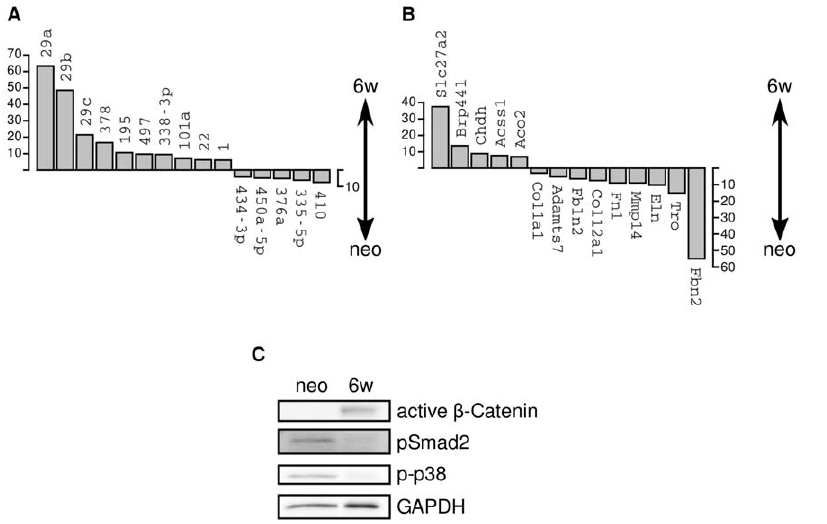
Figure 1. Shifts in mRNA and miRNA expression and TGF- b and Wnt pathway activity in postnatal aortic development. A The fold- change of the normalized expression levels of the most highly differentially regulated miRNAs as measured by microarray hybridization is displayed. B The fold-change of the normalized expression levels of the most highly differentially regulated mRNAs annotated to the GO terms mitochondrion (up-regulated at w6 ) and extracellular matrix (down-regulated at w6 ). (A,B) The fold-change between the neo and w6 aortic samples is shown with the direction of the change being indicated by the arrows. Data are presented as mean of three measurements ( n ~ 3 ). Each mRNA or miRNA had a Benjamini-Hochberg [68] corrected p v 0 : 01 and an absolute fold change of at least 2. C Western Blot analysis with antibodies against active b - catenin, phosphorylated Smad2, and phosphorylated p38. TGF- b responsive Smad2 and p38 were activated in neo aorta and show reduced activity in w6 specimens. By contrast, active (i.e. dephosphorylated) b -catenin was detectable in aortic samples from adult mice only. Equal loading was confirmed by GAPDH staining. Full scans are shown in Supplementary Fig. S2. Samples were run on the same gel.